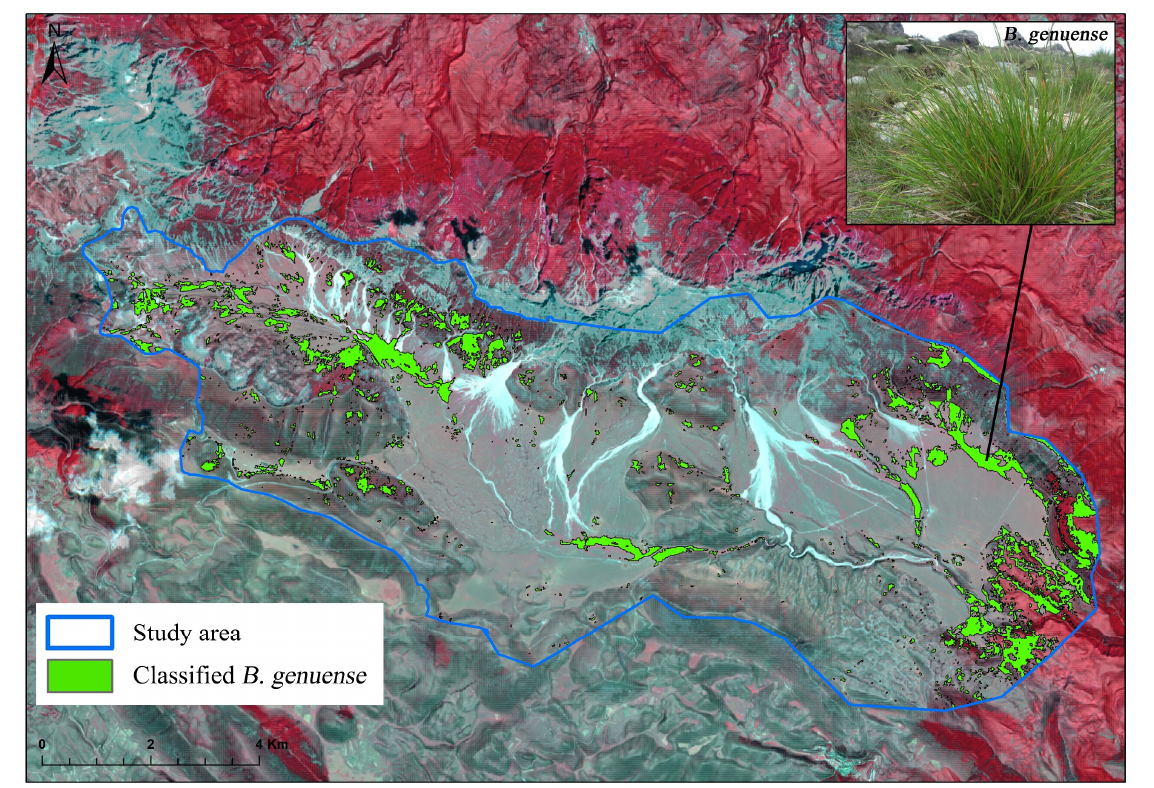
Figure 3. The cover map for Brachypodium genuense in Campo Imperatore showing this grass in light green. The background image is a false-color image by Sentinel-2 (NIR, Red, Green) highlights the most active vegetation on the date of acquisition (25 July 2019). The study area is marked in light blue. In the upper-right part, there are the target species.